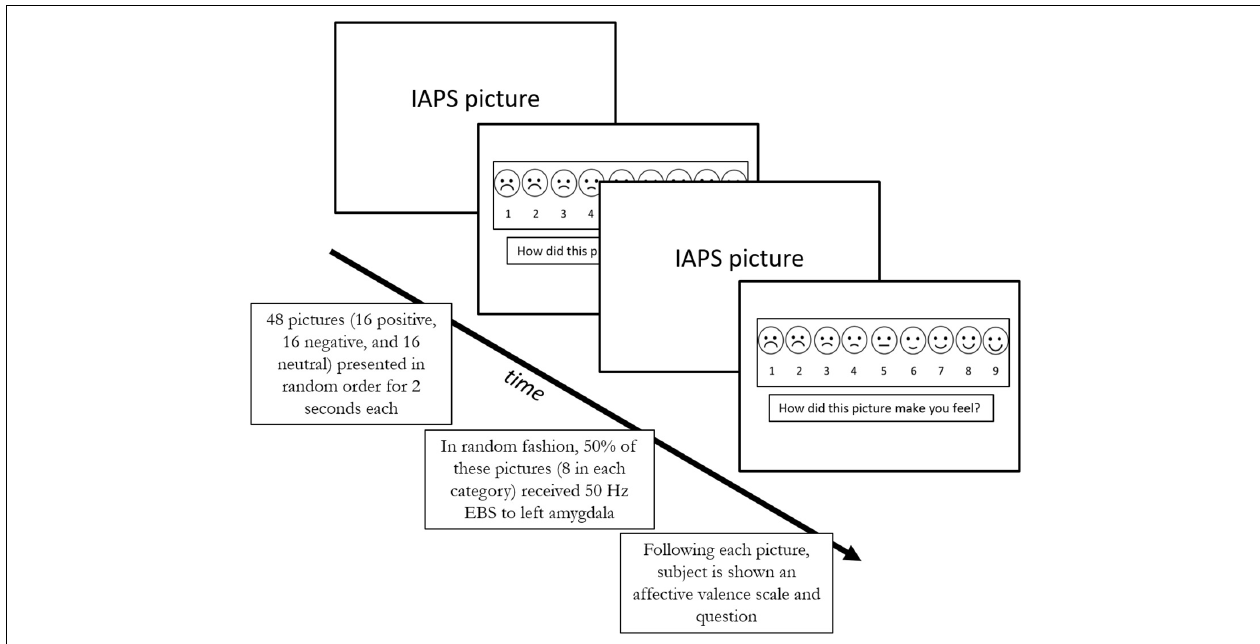
FIGURE 1 | The affective valence perception